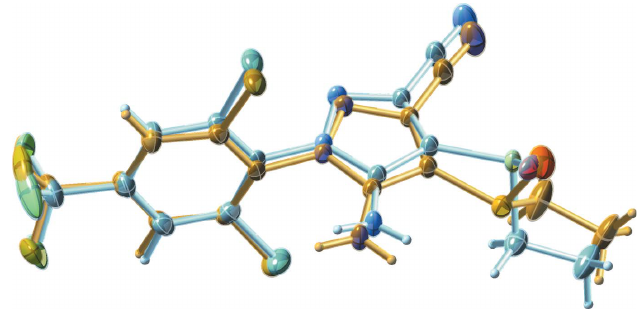
Figure 2 A plot showing the superposition of the minor-disorder component (orange) on the major-disorder component (light blue).